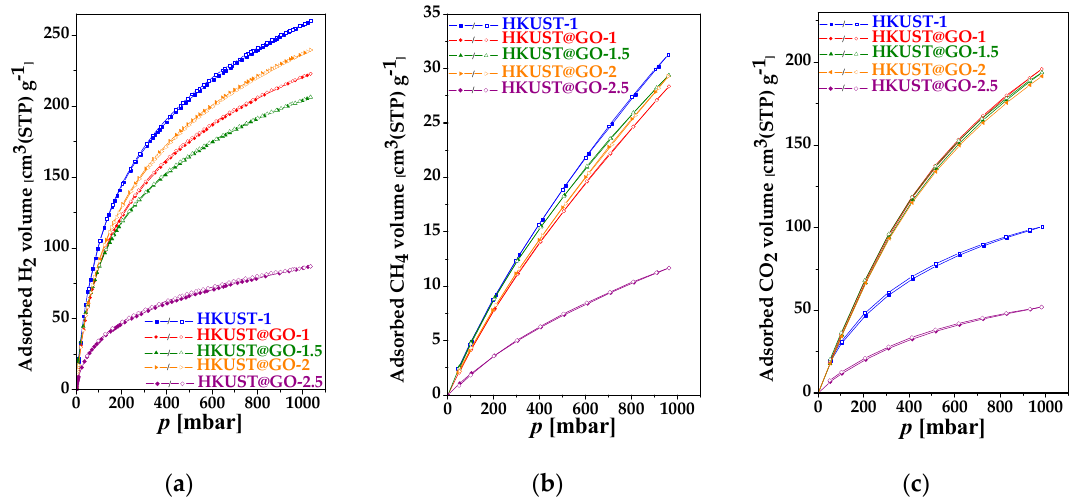
Figure 6. Adsorption capacity of the samples at atmospheric pressure for ( a ) H 2 at − 196 °C and ( b ) CH 4 at 0 °C and ( c ) CO 2 at 0 °C. Table 2. Comparison of the adsorption capacities at atmospheric pressure for N 2 and H 2 at − 196 °C, CH 4 and CO 2 at 0 °C.